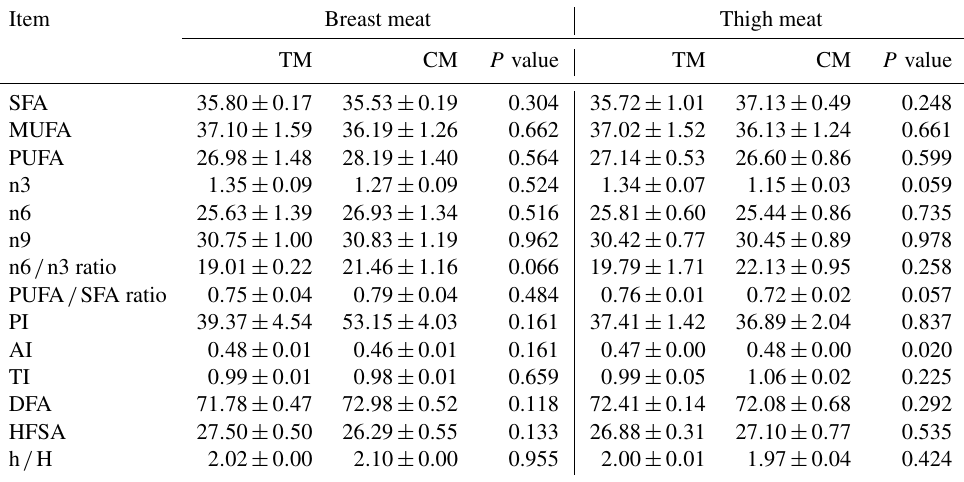
Table 6. Fatty acid profile in breast and thigh meat of guinea fowl in response to diets based on nutrient specifications for turkeys and broilers (Mean ± SEM). Item Breast meat Thigh